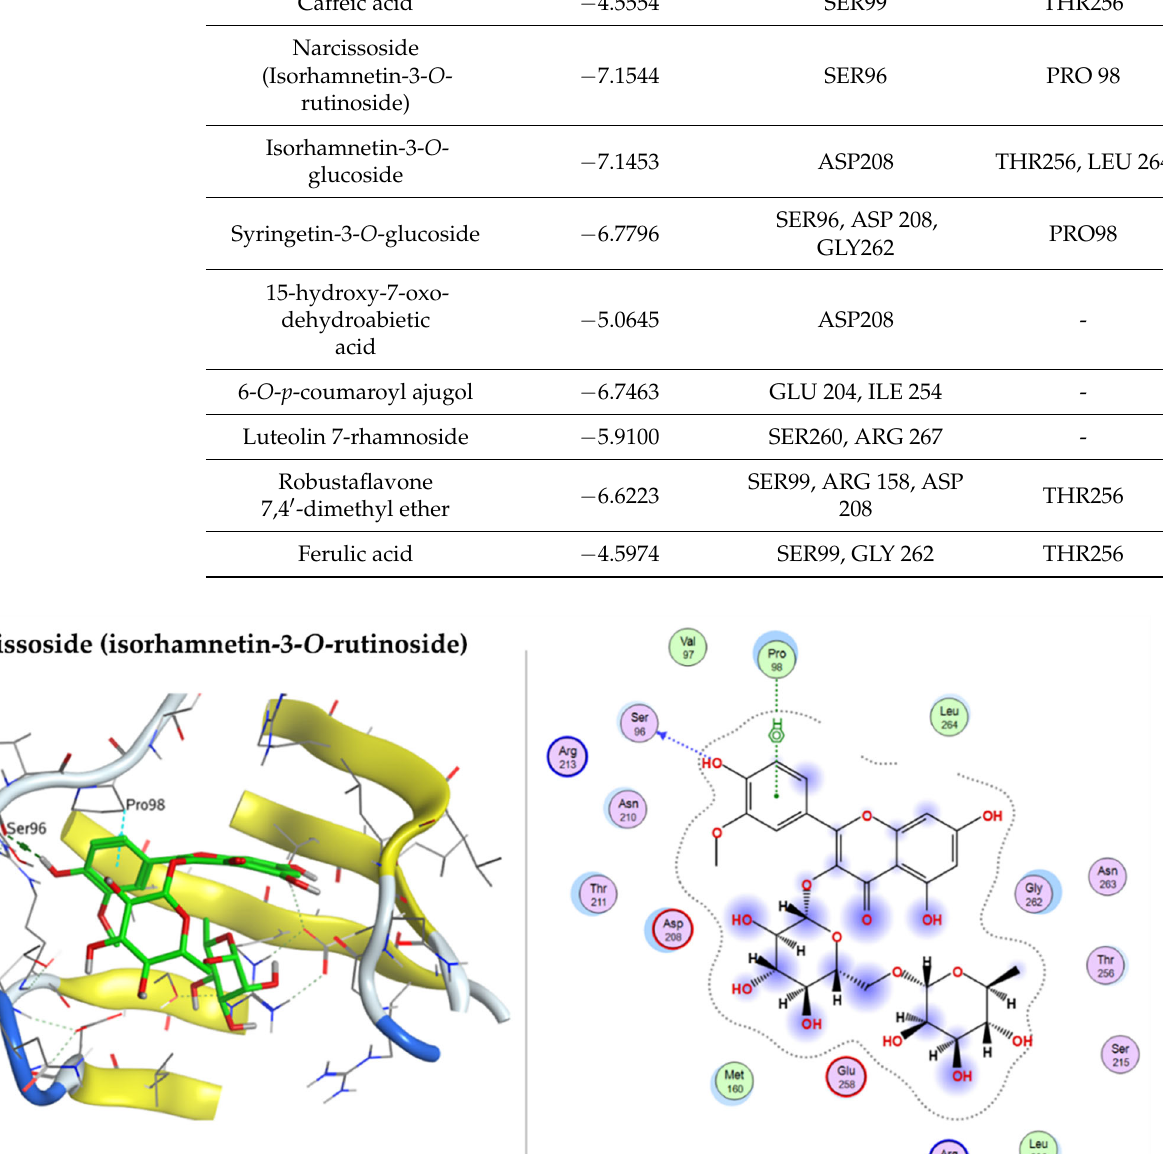
Table 5. Docking details of the selected components of ARBE on P53.